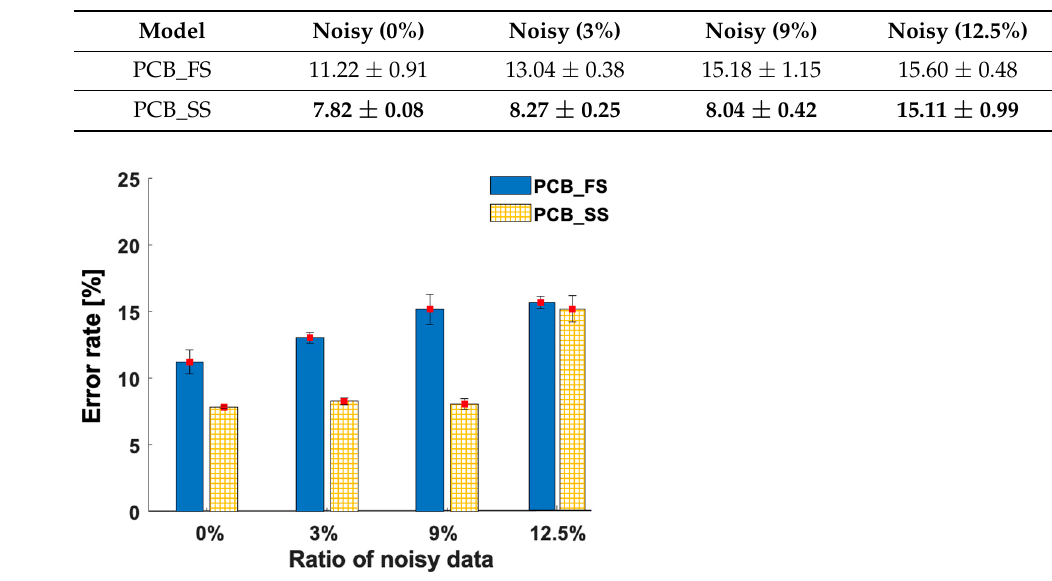
Figure 7. Error rates (%) of the test data with different ratios of noisy data.